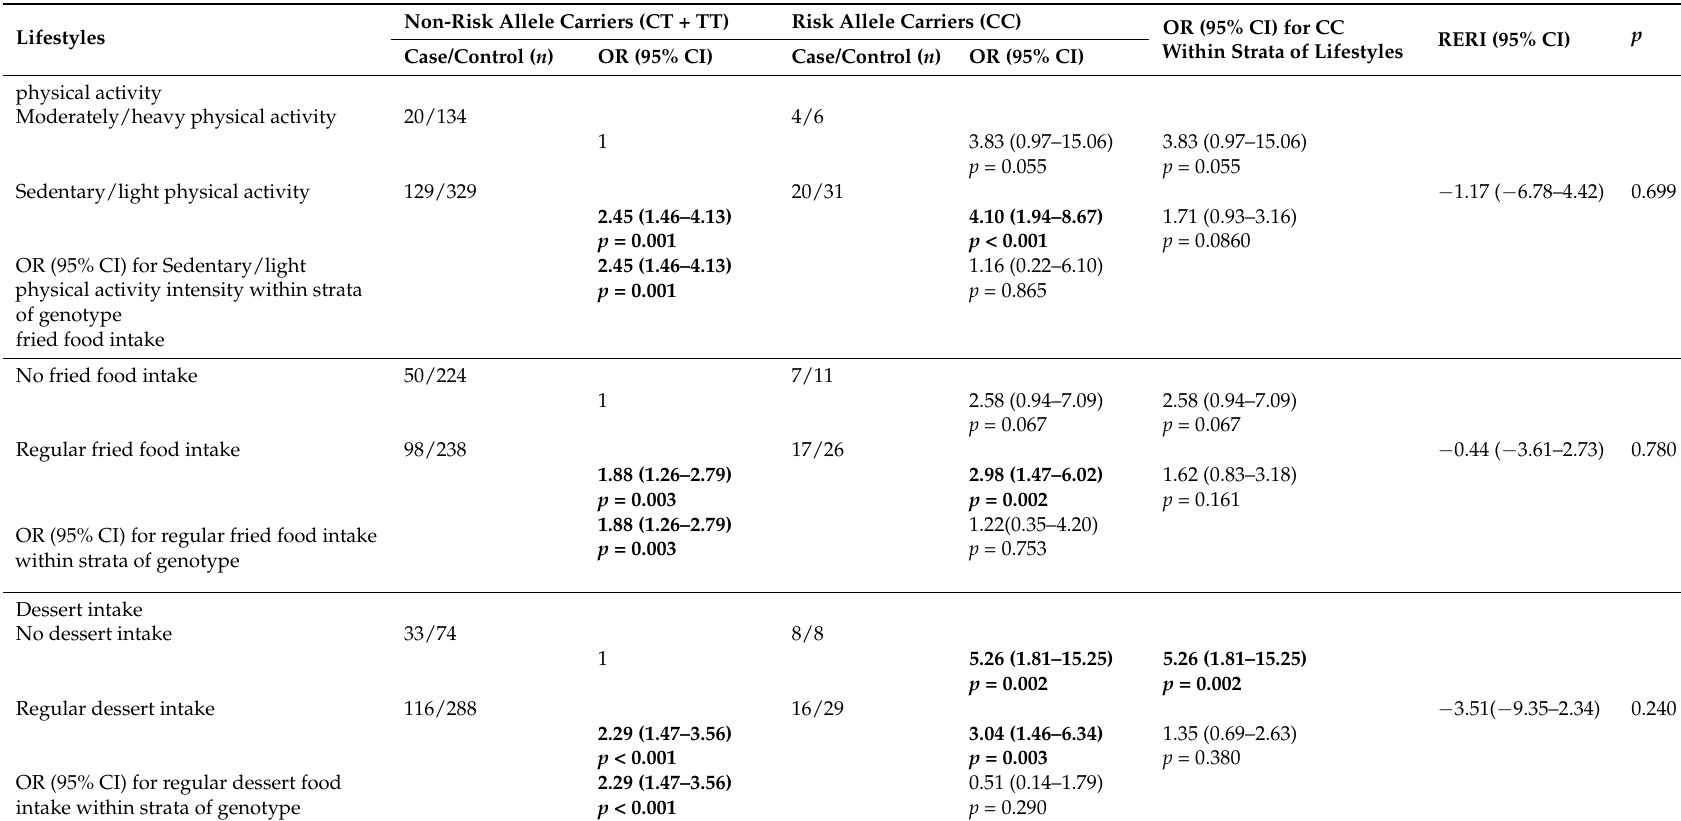
Table 2. Interaction between ABCA1 rs4149339 polymorphism and lifestyles for the risk of